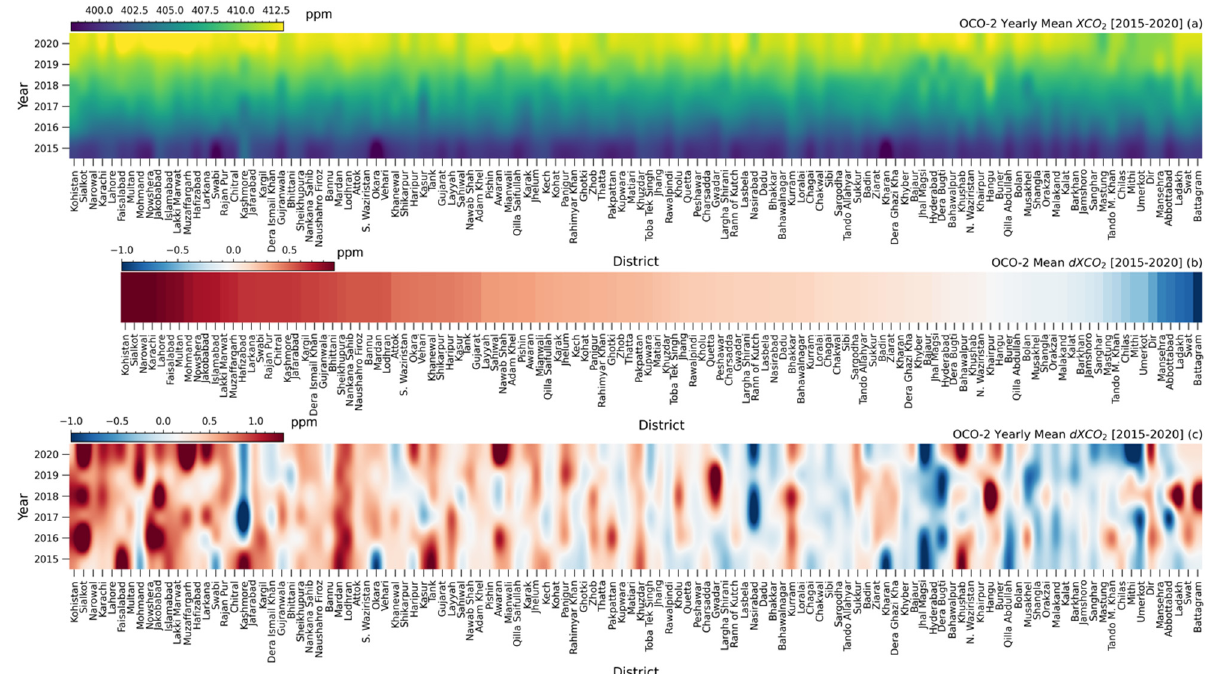
Figure 5. ( a ) Mean annual concentration of XCO 2 , ( b ) ranking of cities based on mean MXCO 2 , and ( c ) mean annual MXCO 2 concentration in districts of Pakistan.